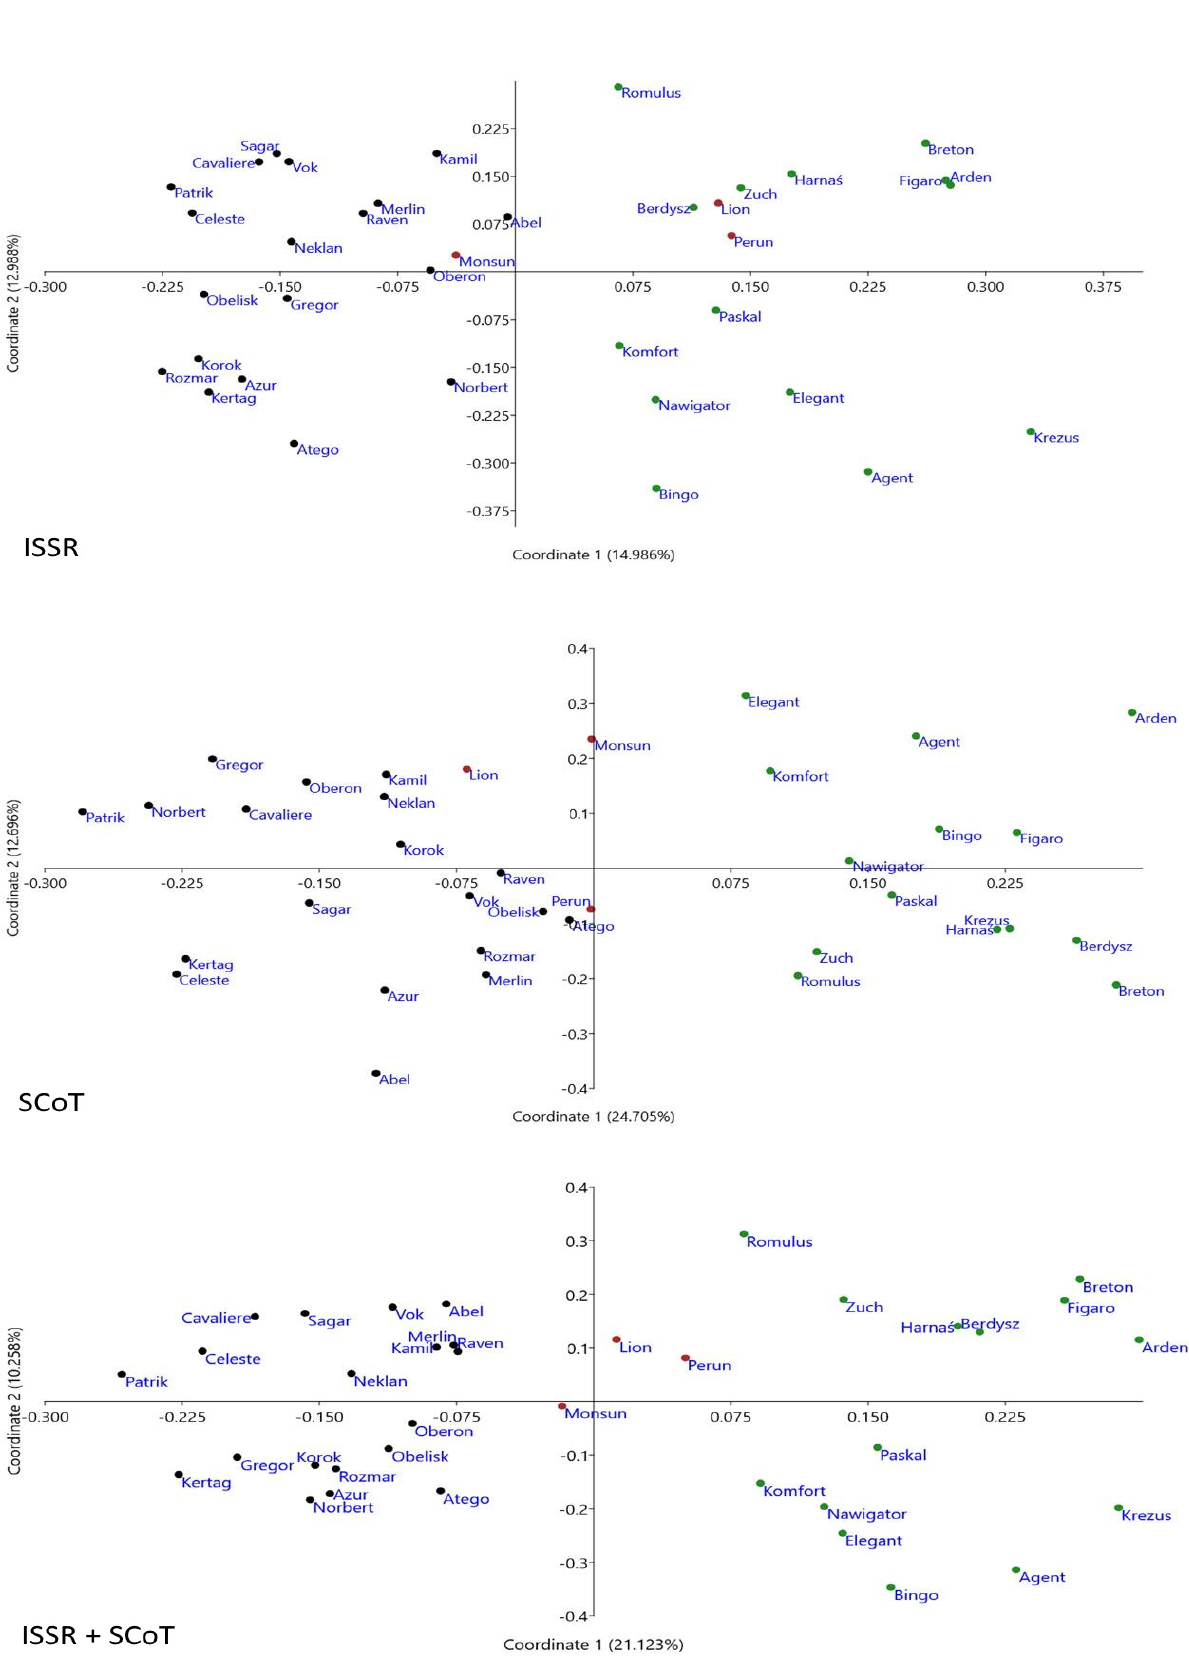
Figure 2 . Biplot of the PCoA analysis of the 36 A. sativa L. cultivars. The origin of the analyzed varieties was marked with the following colors: green, Polish; black, Czech; red, German.